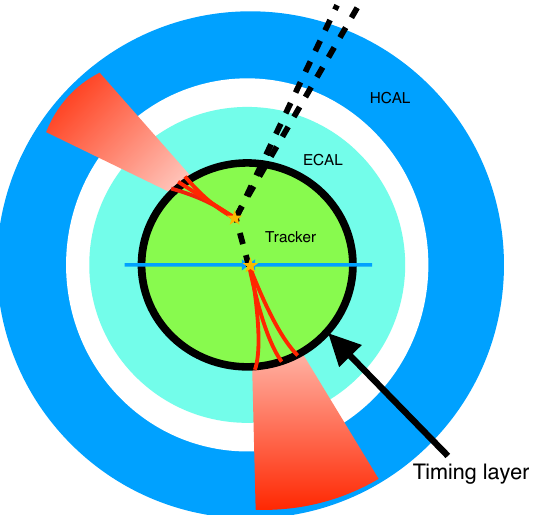
Figure 1 . Schematic layout of an HL-LHC detector with the inclusion of a hermetic timing